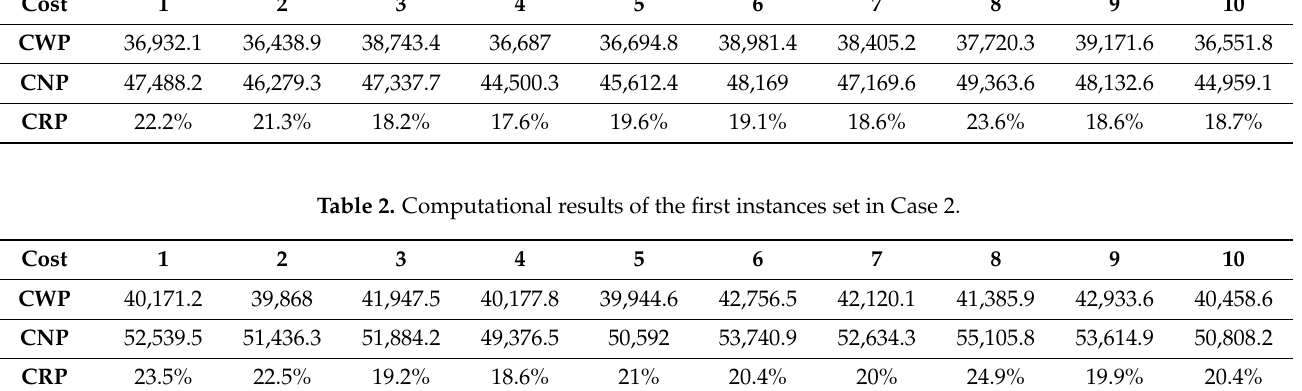
Figure 6. A distribution system with different maximum joint replenishment quantities.